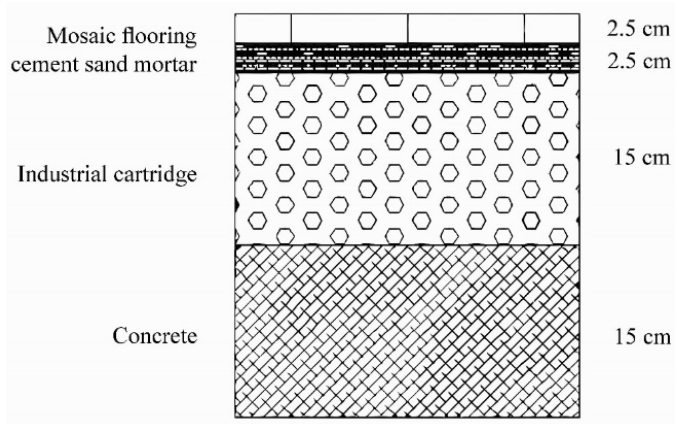
Figure 2. Details of the floor slabs.